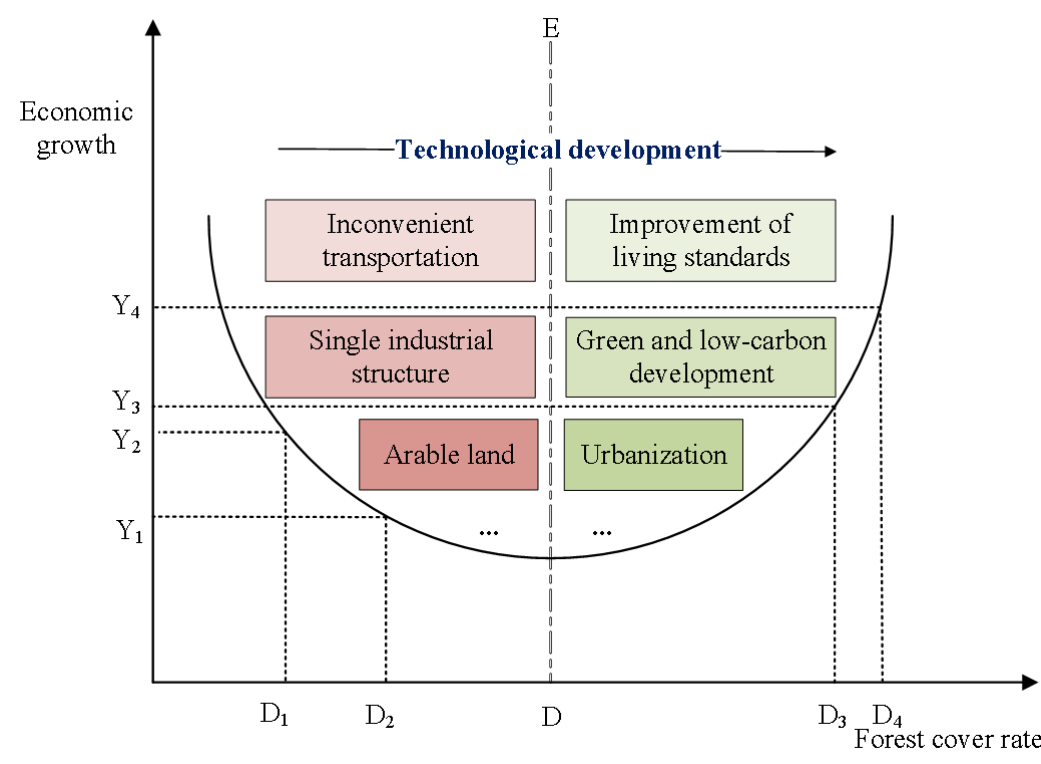
Figure 2. Theoretical framework.